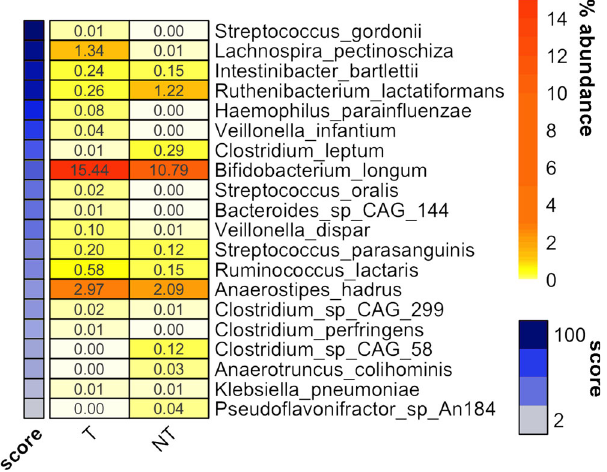
Fig. 3 Gut microbiome features may predict the development of immune tolerance. Heatplot reporting the average relative abundance (%) of microbial taxa signi fi cantly different between food allergy children developing (T) or not (NT) immune tolerance upon 36 months of exclusion diet, as de fi ned by Wilcoxon test (FDR q < 0.1). Taxa are ordered according to the feature importance score from Random Forest classi fi cation model, indicated in the side colored